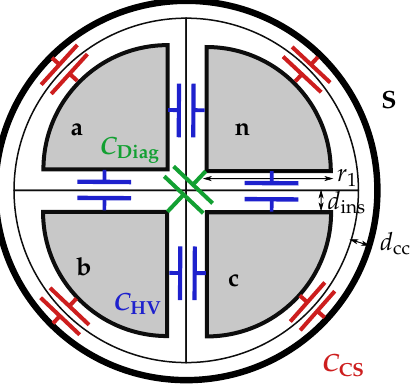
Figure 11. Sector-shaped conductors as ideal quarter circles in four-core NAYCWY